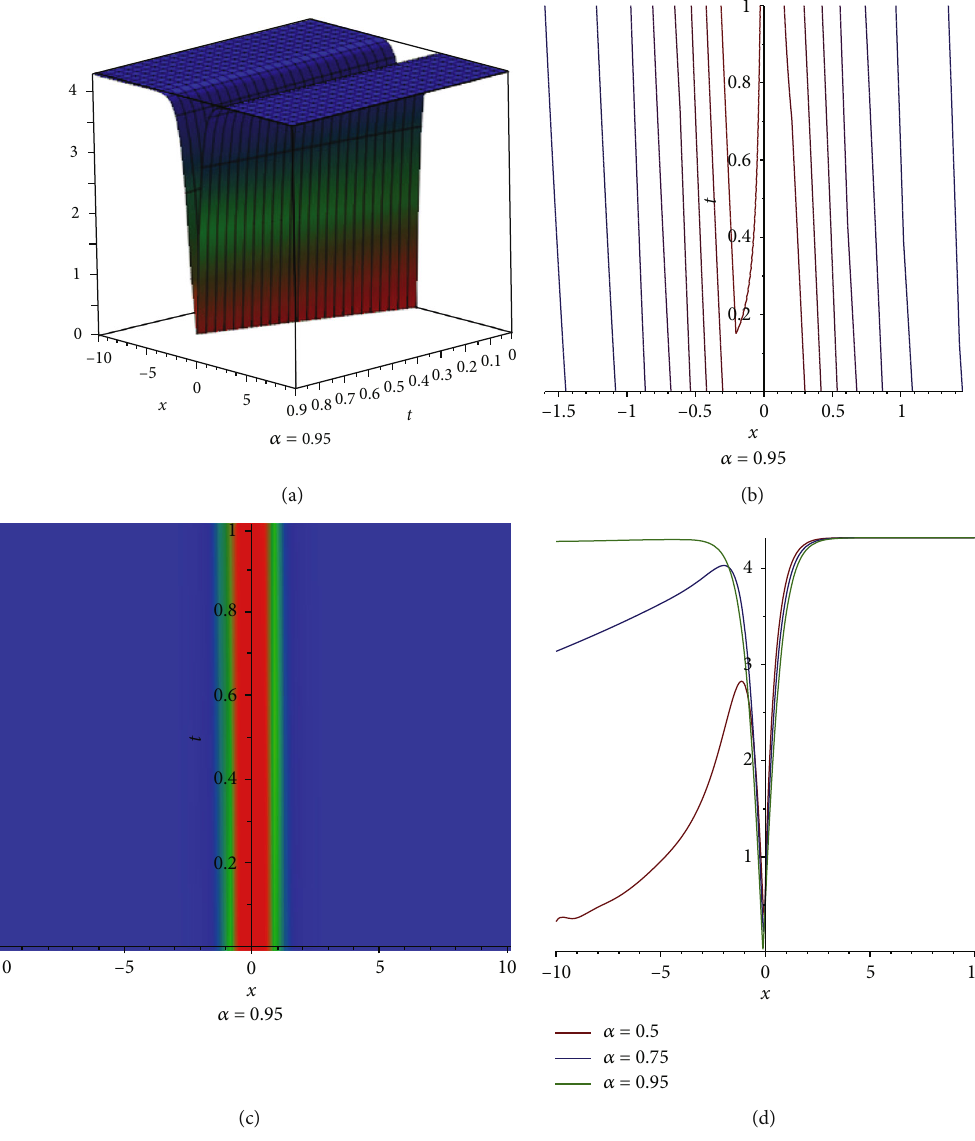
Figure 3: The graphical representations of j U 1